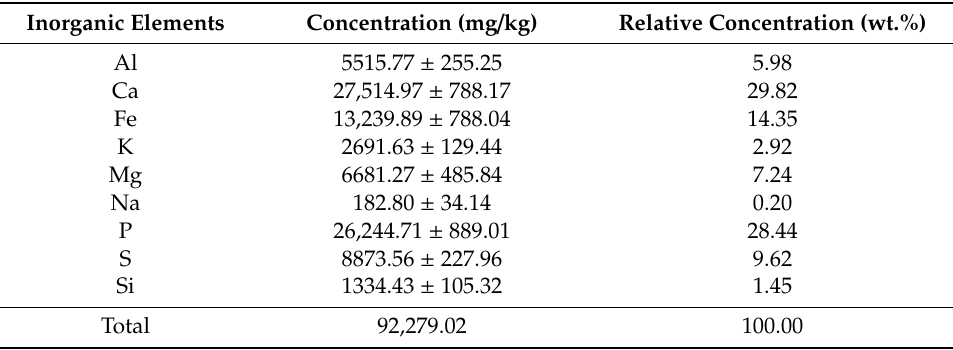
Table 2. Concentration of inorganic elements in